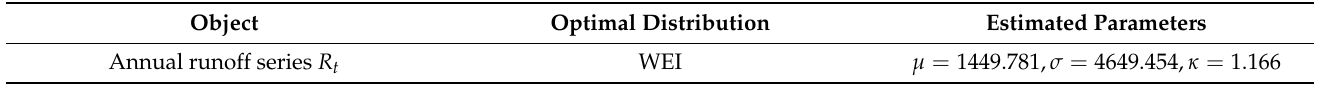
Table 5. Parameter estimation of the optimal distribution for the original annual runoff series of JRB. Object